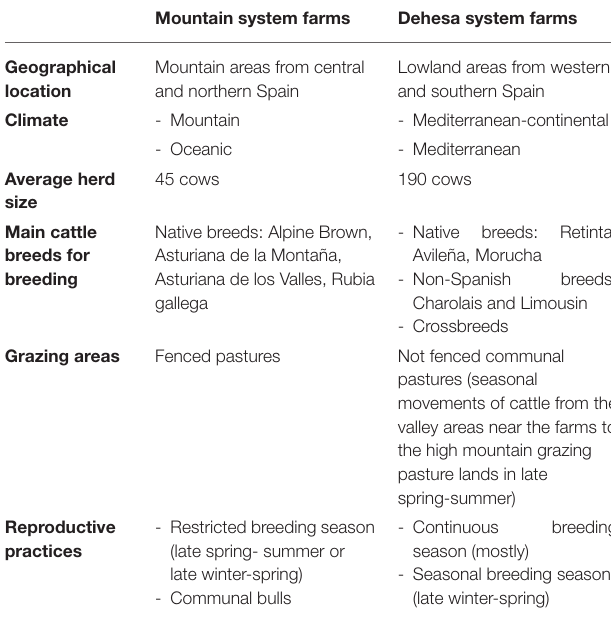
TABLE 1 | Main features of the Spanish extensive management cattle systems included in this